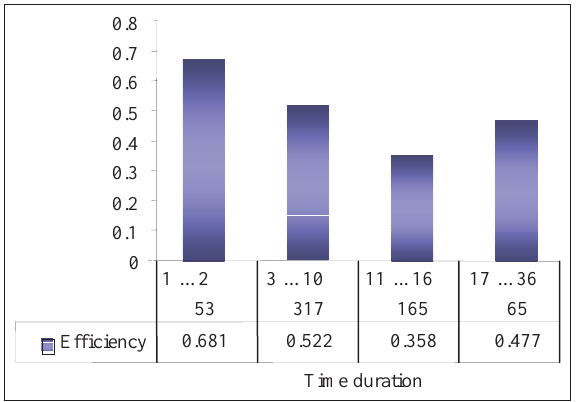
Figure 3. Th e relationship between time in possession in the off en- sive zone and scoring